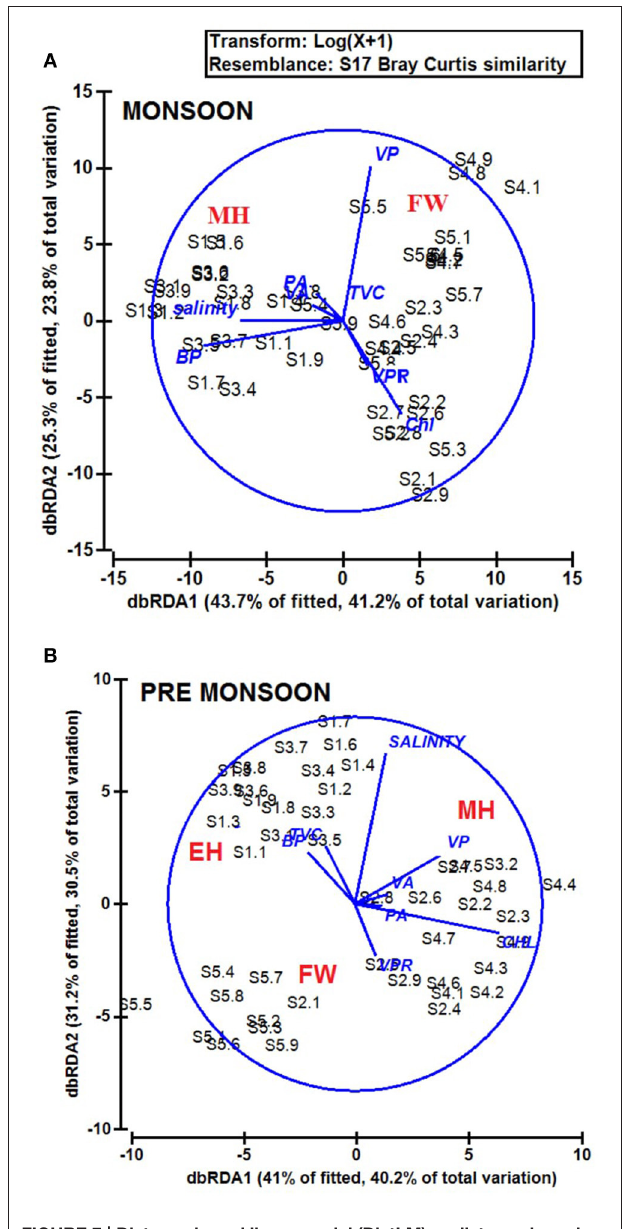
FIGURE 7 | Distance based linear model (DistLM) or distance based redundancy analysis (dbRDA) plot showing the interrelationships of physico-chemical and biological parameters during (A) monsoon (MON) and (B) pre-monsoon (PRM). The fitted model explained 52.7% of the total variation during monsoon and 40.5% variation during pre-monsoon. The % variance explained by dbRDA1 and dbRDA2 is 56.7 and 19.7% in MON and 48.6 and 29.6% in PRM, respectively.